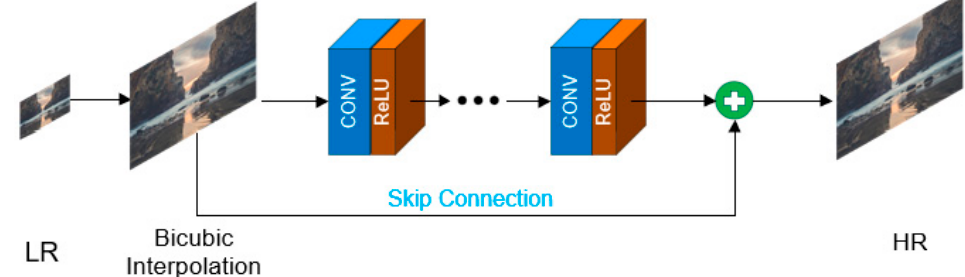
Figure 5. VDSR network structure (ReLU stands for Rectifier Linear